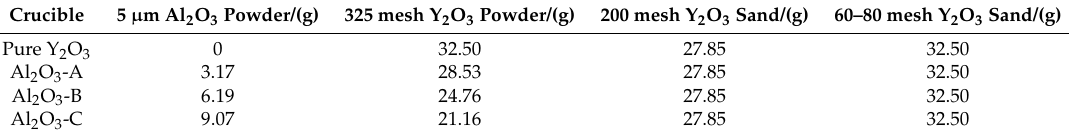
Table 1. Designated composition of composite crucibles with different Al 2 O 3 contents.